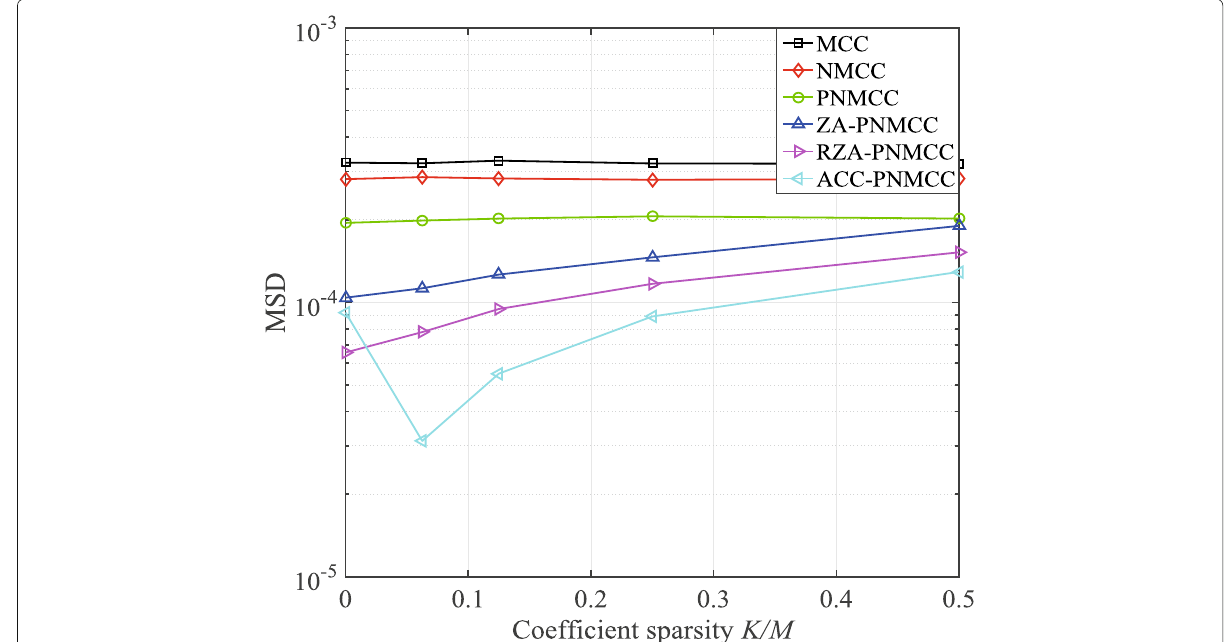
Fig. 8 The MSD performance of the proposed ACC-PNMCC algorithm with different coefficient